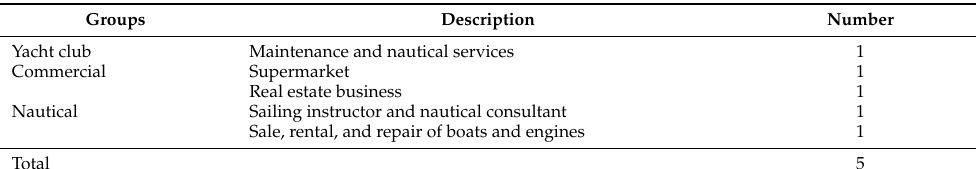
Table 1. Participants and affiliations